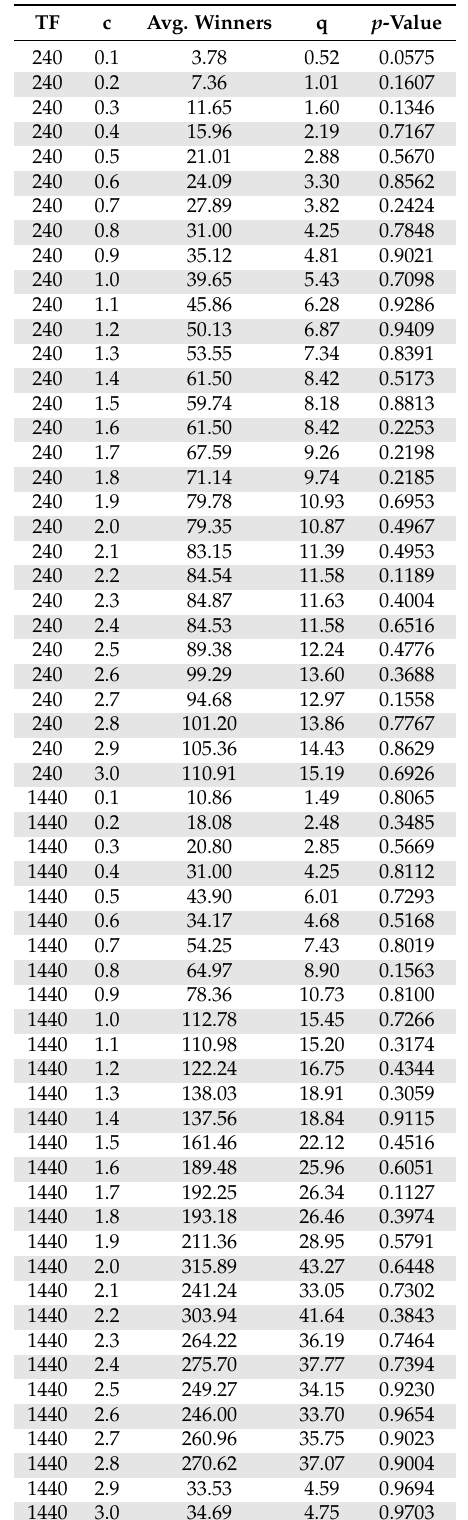
Table 9. Coefficient c and respective p -values for timeframes of 240 and 1440